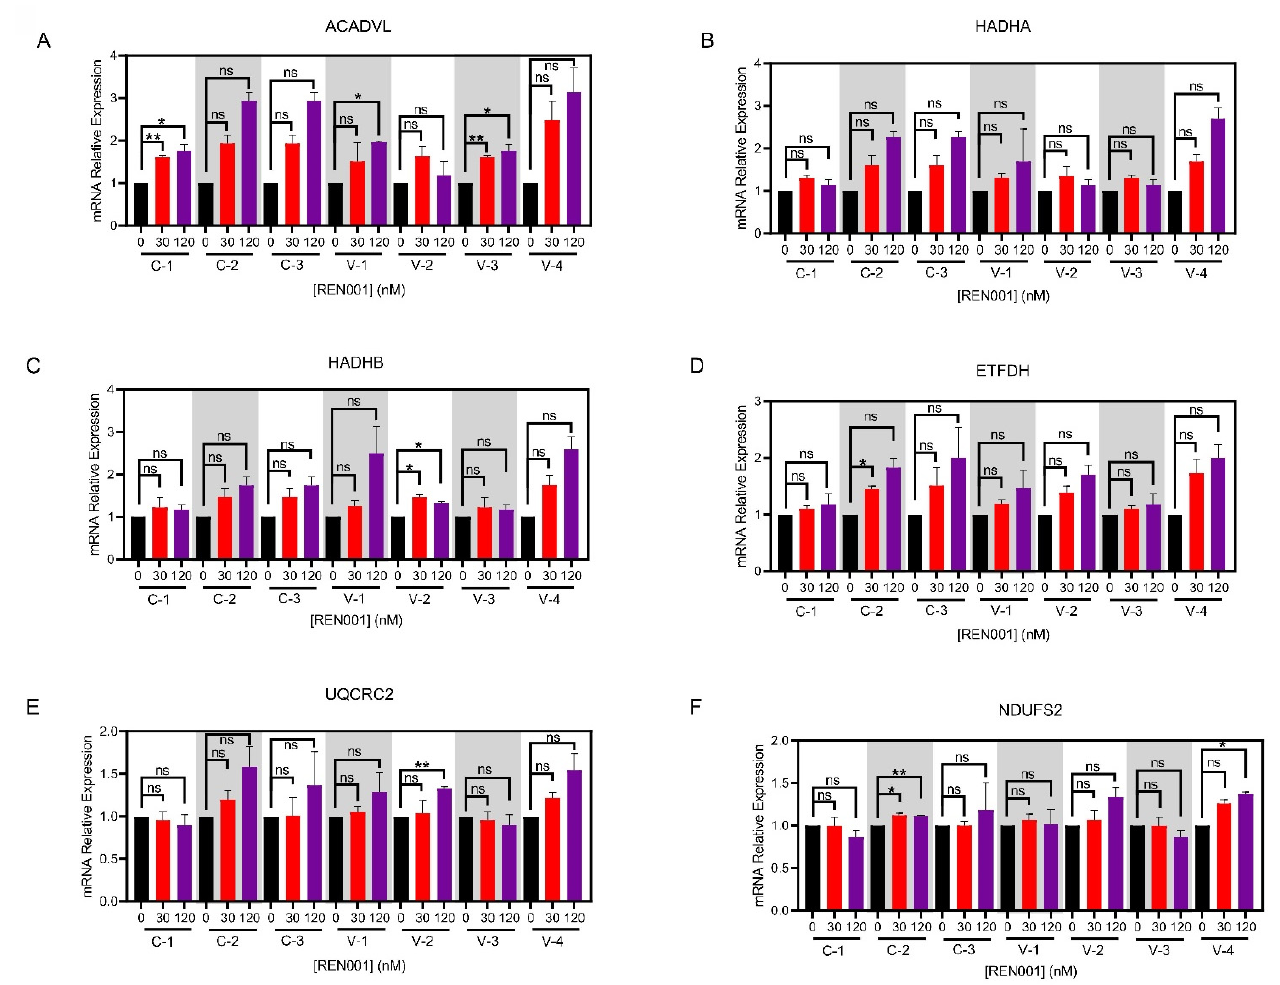
Figure 1. qPCR in control (C-1, 2, 3) and VLCAD-deficient (V-1, 2, 3, 4) fibroblasts ( A – F ) treated with REN001 at 30 or 120 nM final concentration for 48 h. Bars represent mean and standard deviations. * p < 0.05, ** p < 0.01, *** p < 0.001, ns = not significant, compared to value at 0 nM treatment (n = 3 for all assays; t -test for unpaired samples).